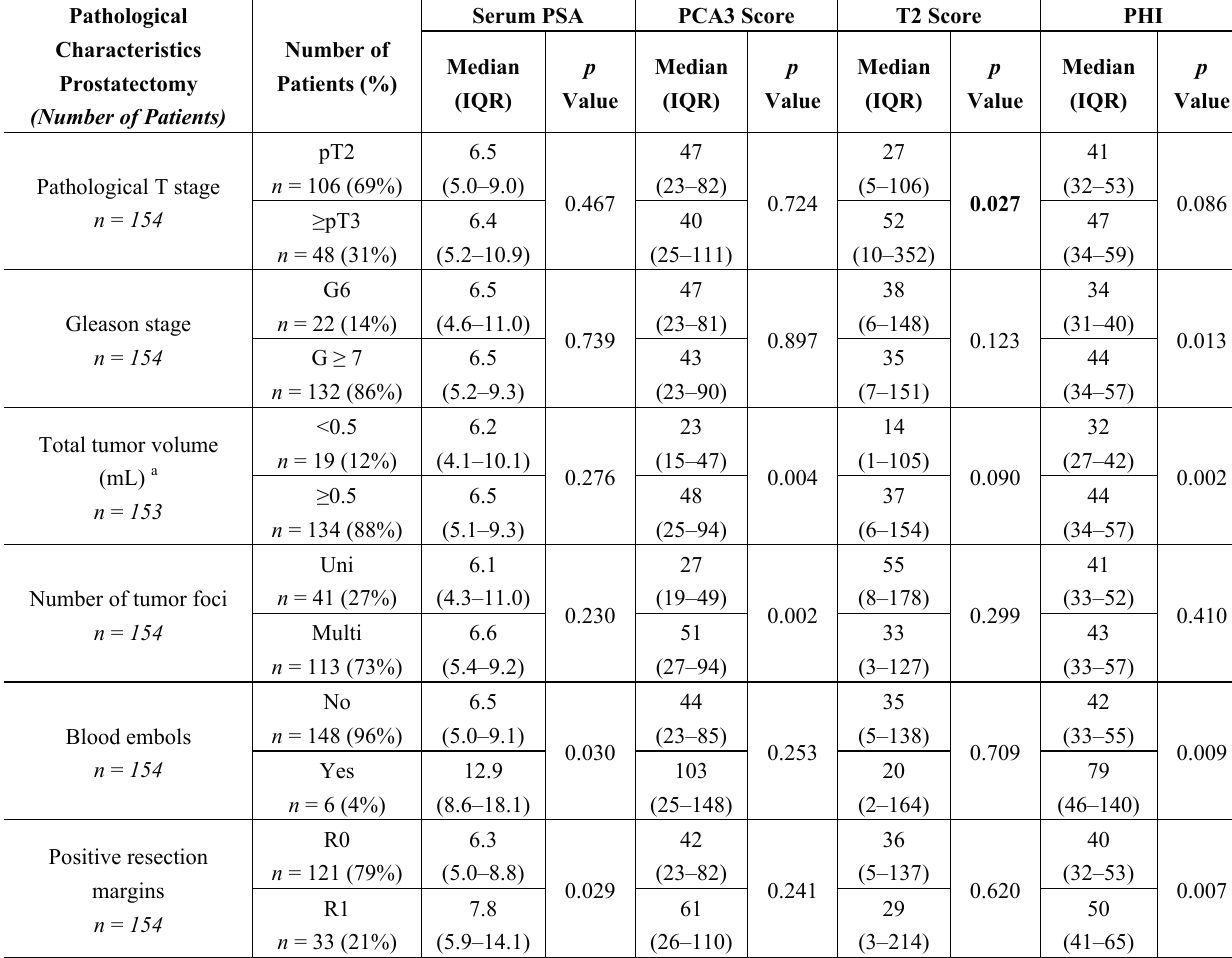
Table 2. Pathological characteristics of the tumors in prostatectomy specimens and correlations with serum PSA (Prostate-Specific Antigen), PHI (Prostate Health